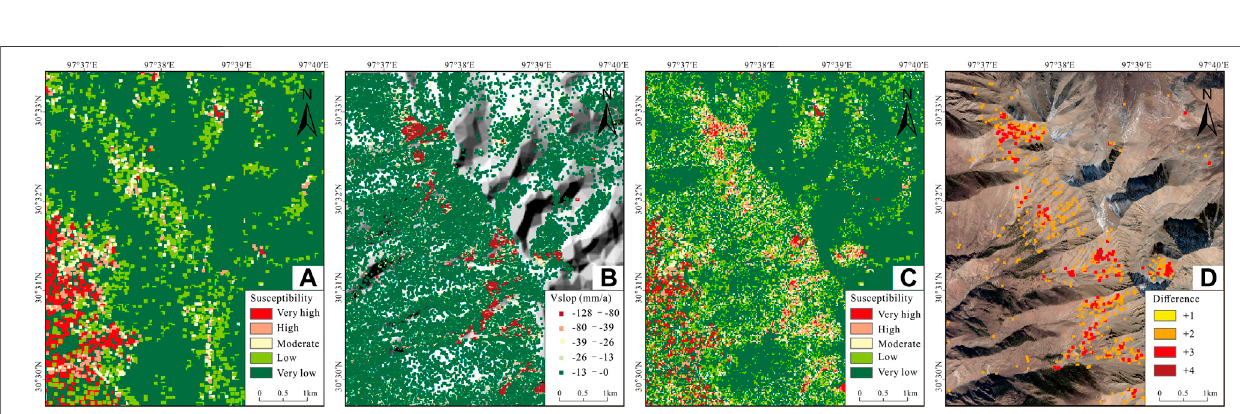
FIGURE 11 | Landslide assessment results for area No. 2 (Xueru area). (A) landslide susceptibility assessment results obtained using the FR-RF model. (B) Deformation rates in the slope direction obtained by the SBAS-InSAR method. (C) optimized landslide susceptibility assessment results. (D) changes in landslide susceptibility grades before and after re fi